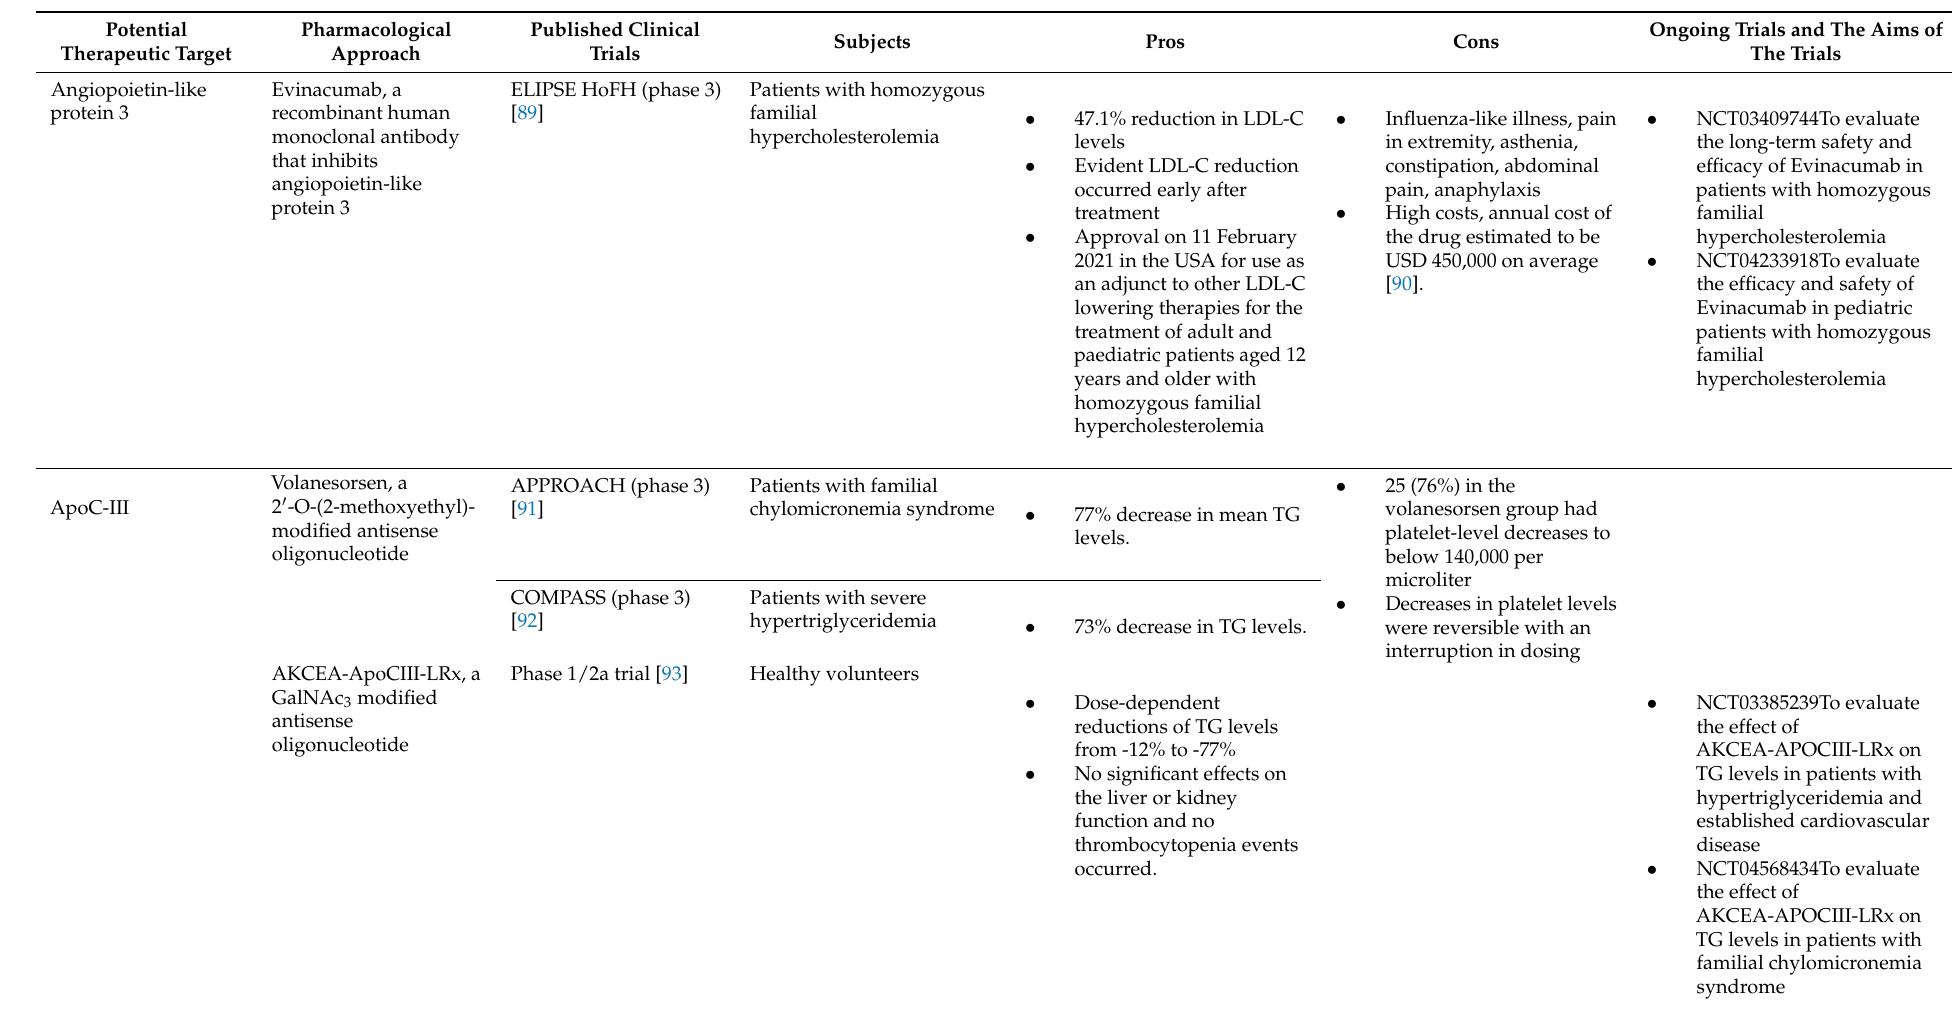
Table 1. Potential therapeutic targets and emerging pharmacological lipid-lowering